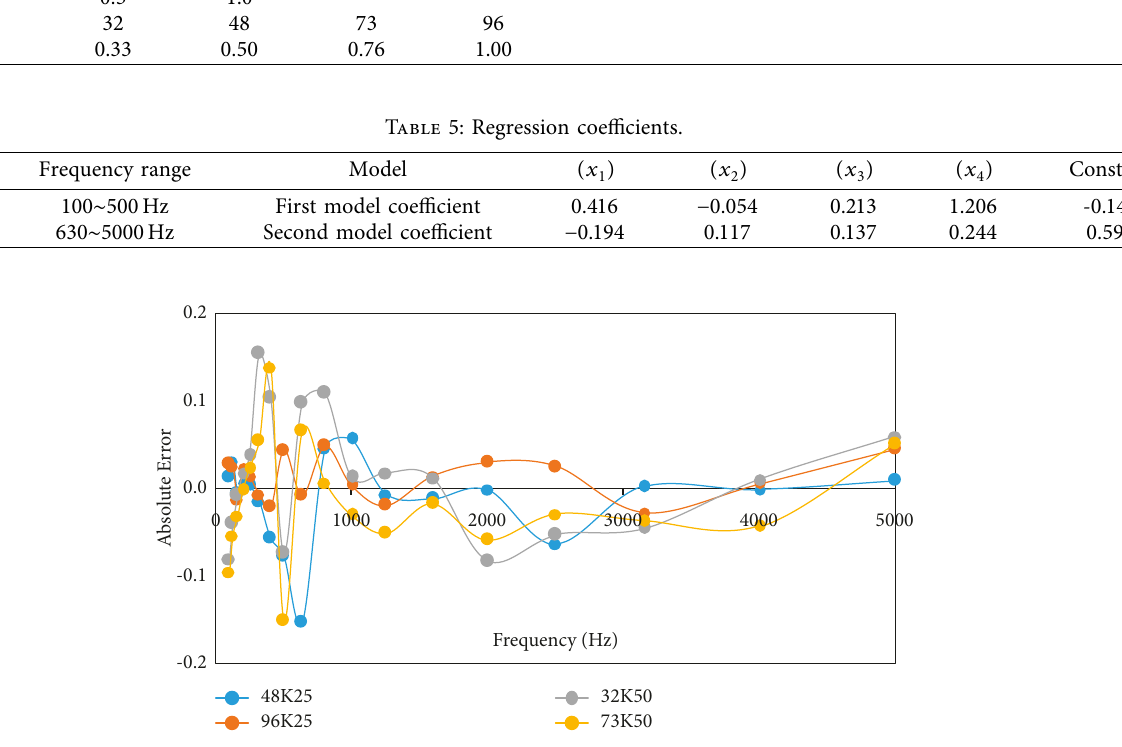
Figure 9: Absolute errors between the estimated results and true values of four samples.